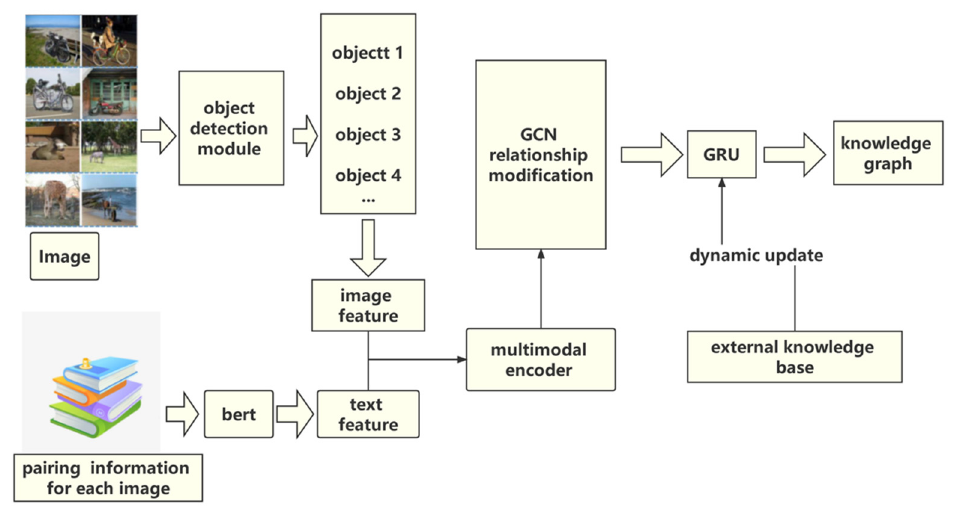
Figure 2. This model consists of four parts: the object detection module, the GCN relationship modification, the multimodal encoder, and the gated recurrent unit (GRU). The role of the object detection module is to extract different areas of the image. The purpose of the GCN relationship modification is to establish the relationship between different regions of the image. The multimodal encoder obtains node features more perfectly, and the GRU is an iterative, updated module.